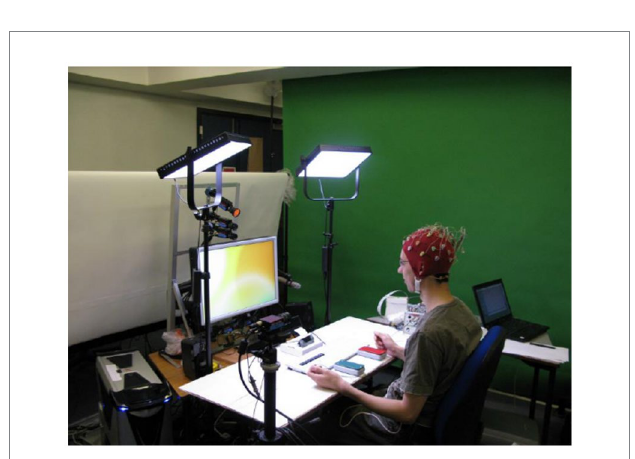
FIGURE 6 Collection scene for the MAHNOB-HCI database (Soleymani et al., 2014). Reproduced with permission from IEEE. Licence Number: 5493400200365.